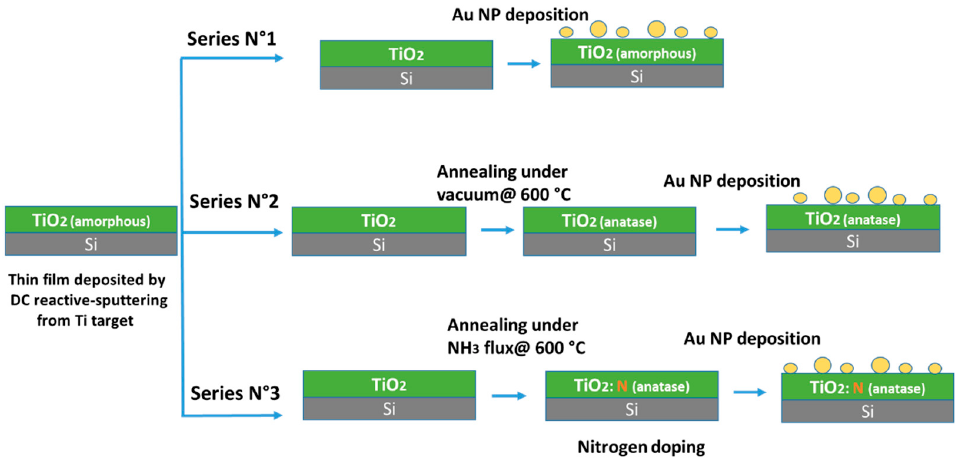
Figure 1. Flow diagram showing all the steps towards synthesis of Au NP ‐ supported TiO 2